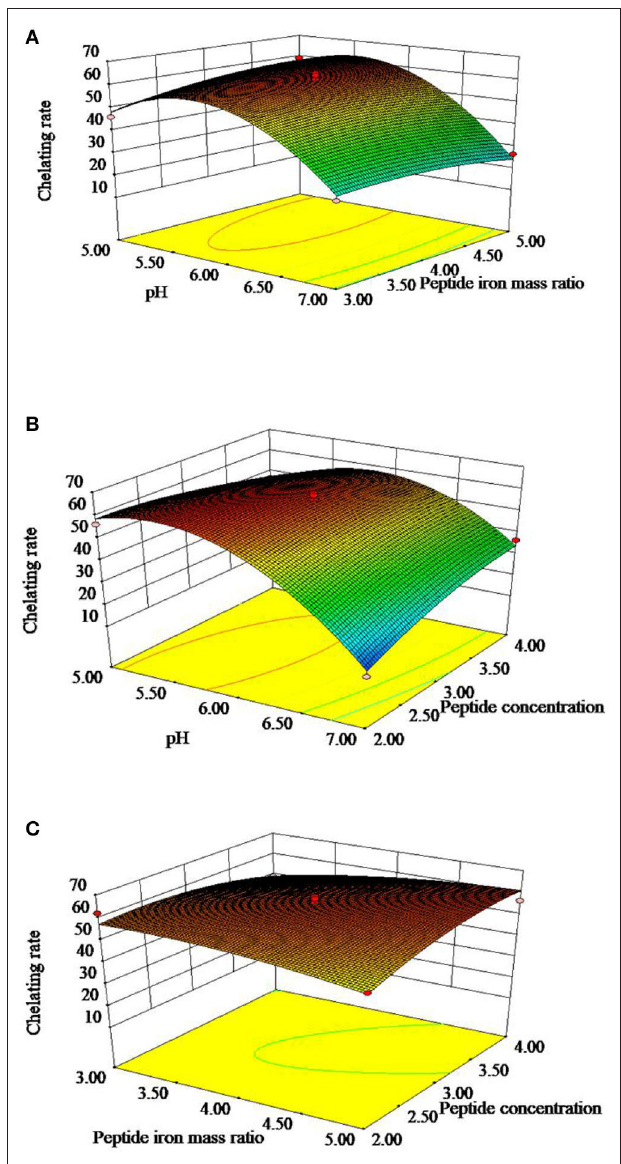
FIGURE 2 | Response surface plots showing effect of peptide concentration, pH, and peptide iron mass ratio on chelating rate of OP-Fe 2 + .